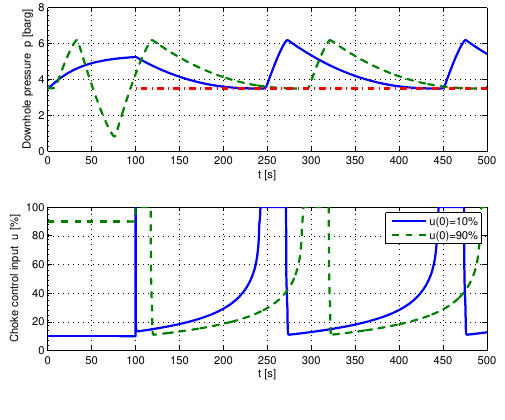
Figure 4: Simulations of an attempt to stabilize at p ref = 3 . 49, which is below what is physi- cally